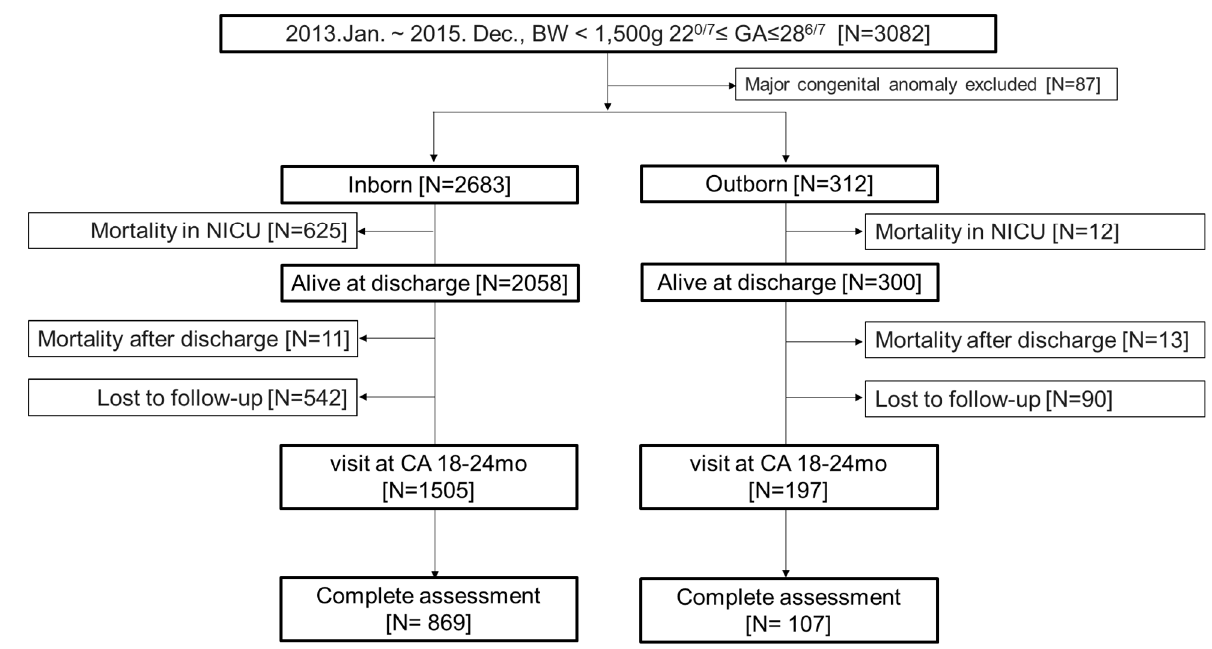
Figure 1. Flow chart of inborn and outborn infants from birth to follow-up. Analyzed data ( n = 2995: inborn, 2683; outborn, 312) were obtained from the Korean Neonatal Network Database (2013–2015). GA, gestational age; CA, corrected age.